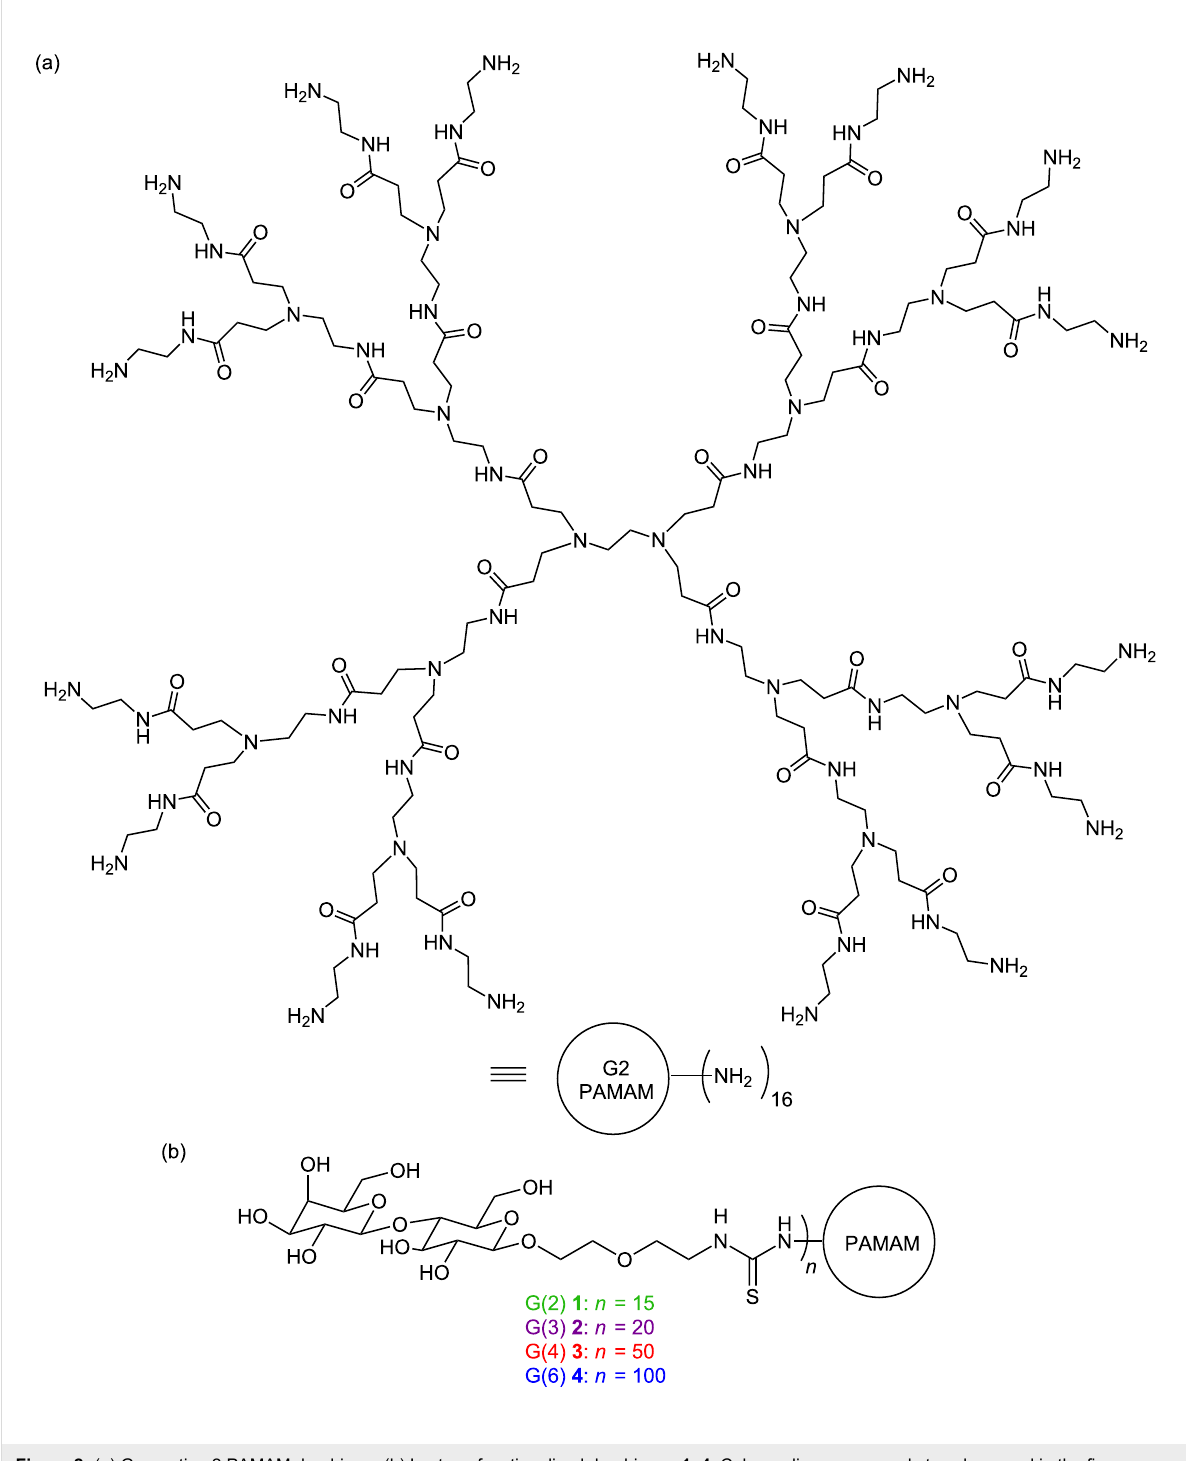
Figure 2: (a) Generation 2 PAMAM dendrimer. (b) Lactose-functionalized dendrimers 1 – 4 . Color-coding corresponds to colors used in the figures throughout this publication to indicate the different glycodendrimer generations.